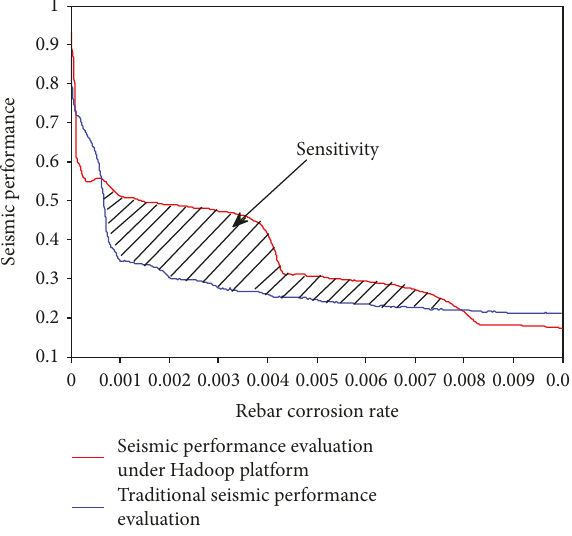
Figure 8: Floor displacement of di ff erent fl oors.